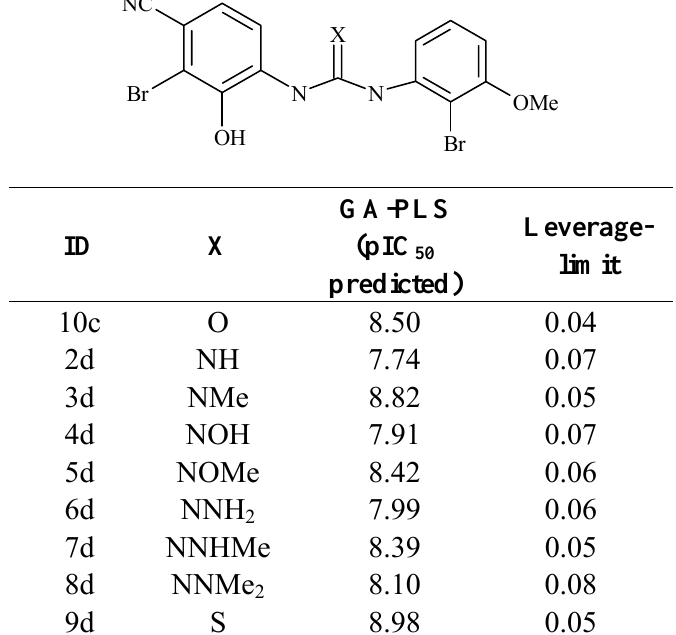
Table 16. Structural modification of CXCR2 receptor antagonists and predicted